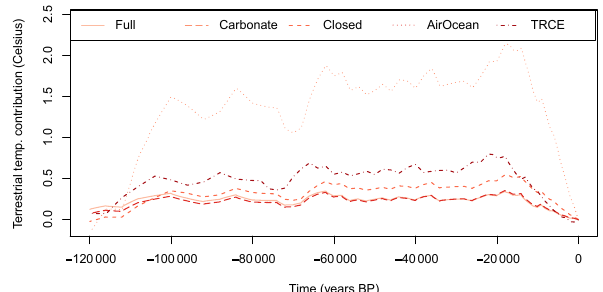
Figure 7. Temperature changes resulting from the same terrestrial carbon emissions scenario (GCI_ELE) with different model setup for cGENIE and for the TRCE of HadCM3. The cGENIE simula- tions were “Full”, with silicate weathering feedback and just car- bonate compensation, as Lord et al. (2016); “Carbonate”, with just carbonate compensation only, as Ridgwell and Hargreaves (2007); “Closed”, with no weathering or sediment response, and hence just ocean–atmosphere repartitioning; and “AirOcean”, where the car- bon remains in the atmosphere. “TRCE” is the simple calculation of the TRCE of HadCM3 (taken from Matthews et al., 2009) for the same carbon inputs into the atmosphere as used for the cGENIE simulations. Note that we include the TRCE for completeness, but it is not a cGENIE simulation (see Methods